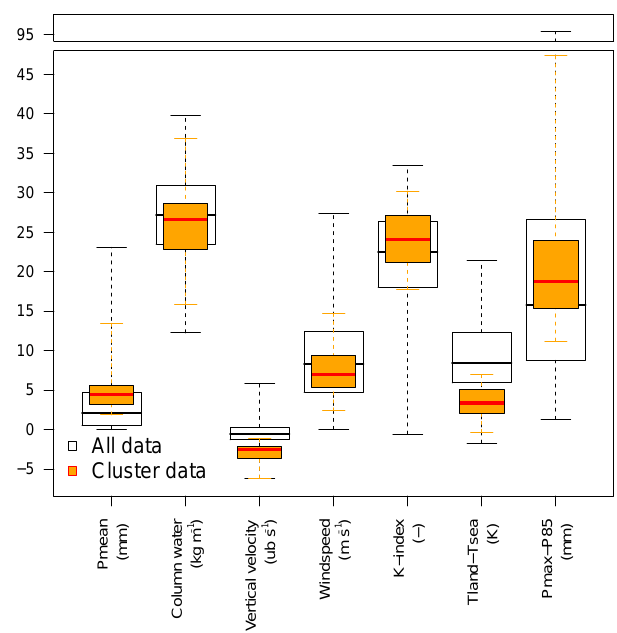
Figure 2. Boxplots of the seven parameters used in the procedure to select days to simulate with the WRF model. Boxes of the days included in the selected cluster are given in orange and boxes of all summer days classified as WT 9 in the period 2000–2010 are given in